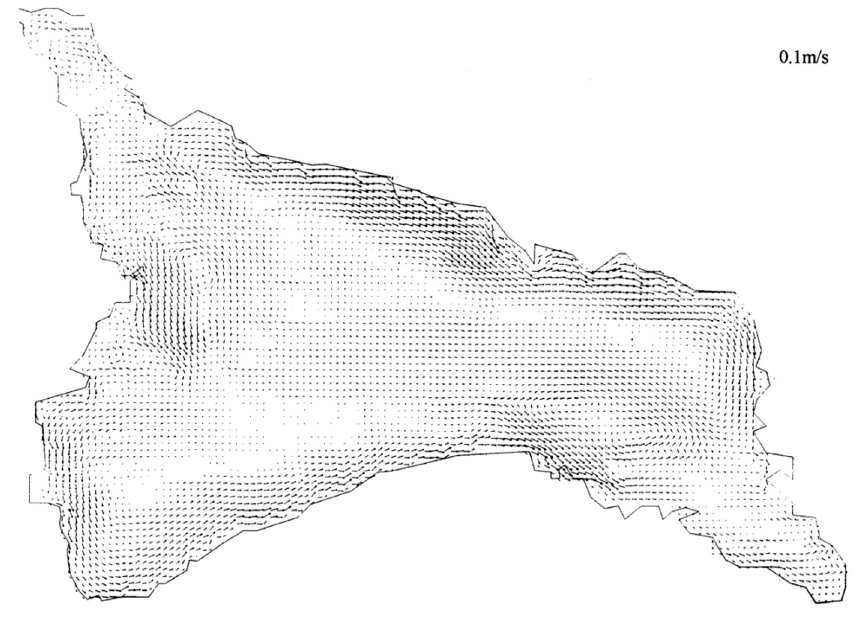
Figure 7. The simulated current results by Han et al. (2004) [24].